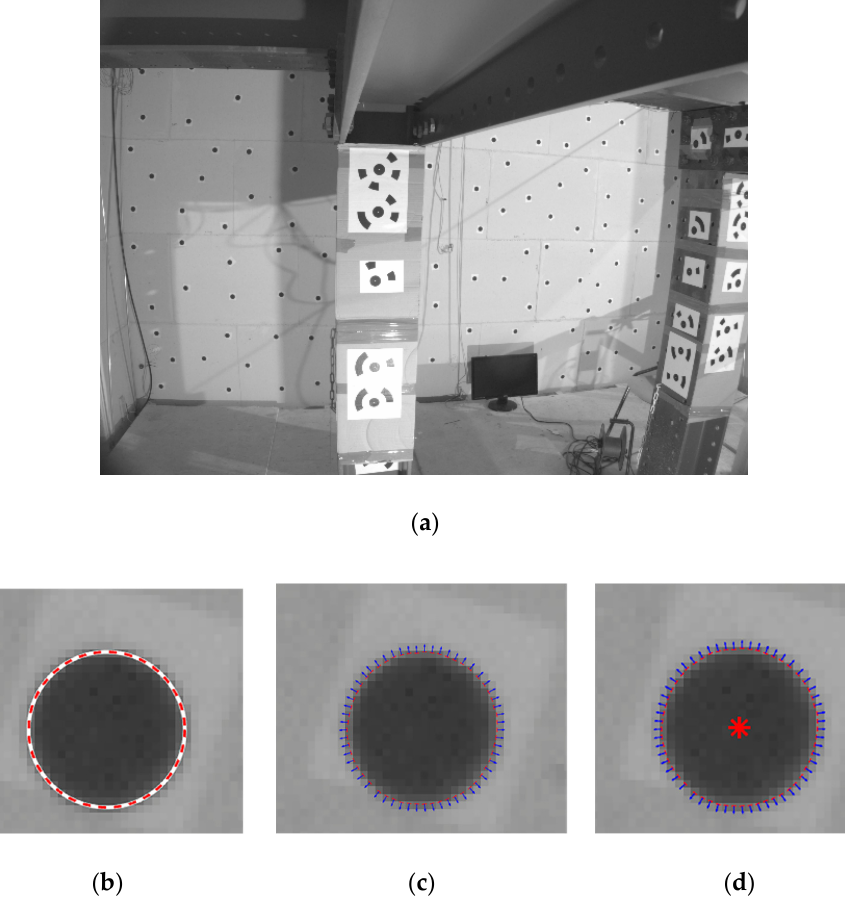
Figure 7. Results obtained during the detection of the target center: ( a ) general view of one image captured during the test; ( b ) detailed view of the results obtained by the Hough transform; ( c ) detailed view of the sub-pixel edge detector; ( d ) center obtained after the non-linear optimization. Table 2. Inner parameters of the camera obtained from laboratory calibration and after the self-calibration.